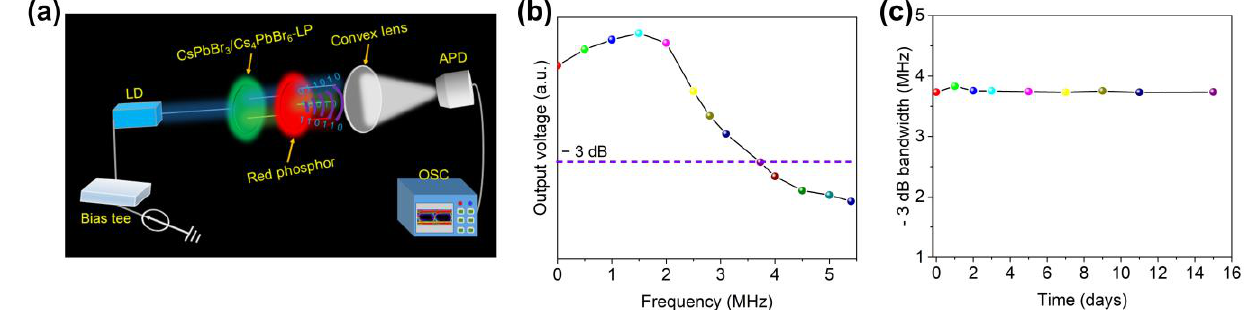
Figure 9. ( a ) Schematic diagrams of the VLC test system. ( b ) Frequency response of the CsPbBr 3 /Cs 4 PbBr 6 – LP-based WLEDs. ( c ) The −3 dB bandwidth of CsPbBr 3 /Cs 4 PbBr 6 – LP-based WLEDs after exposure to the air.